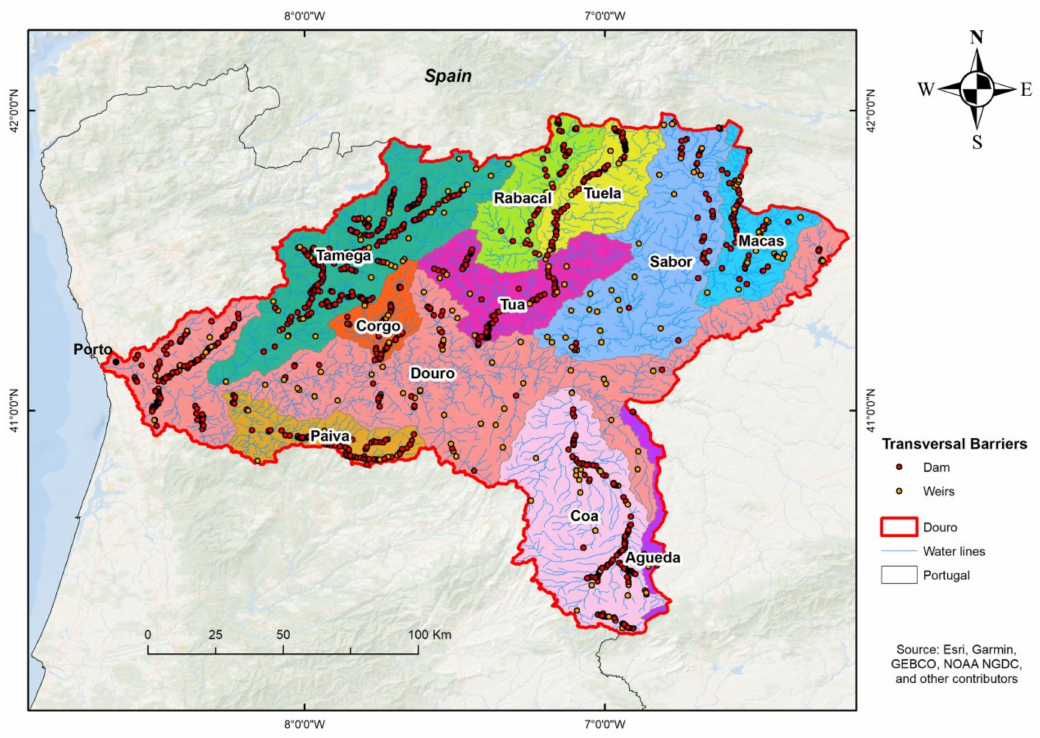
Figure 4. Spatial distribution of dams and weirs within the Portuguese side of the Douro River